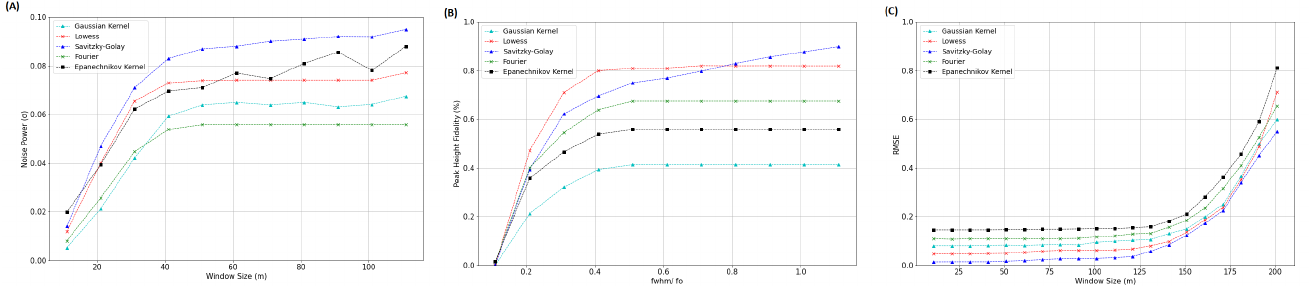
Figure 5. Comparison of performance of Adaptive Savitzky–Golay filtering with peer filtering methods. ( A ): Comparison based on noise power; ( B ): Comparison based on peak height fidelity; ( C ): Comparison based on smoothing